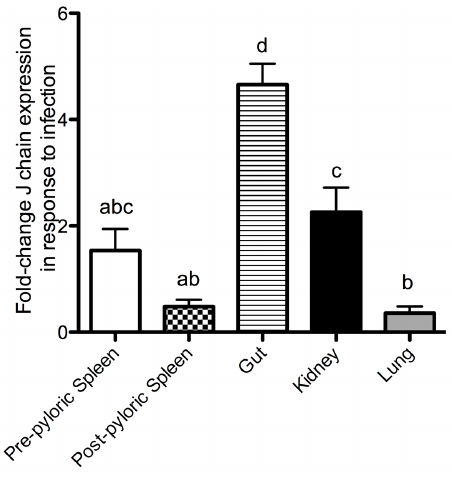
Figure 5. Fold change of J chain expression in pre-pyloric spleen, post-pyloric spleen, gut, kidney and lung of Nigerian spotted lungfish infected with Edwardsiellaictaluri compared to samples from PBS mock control fish. Bars represent means 6 standard error of four fish. Different letters represent statistically significant groups after Tukey’s test (p , 0.05).